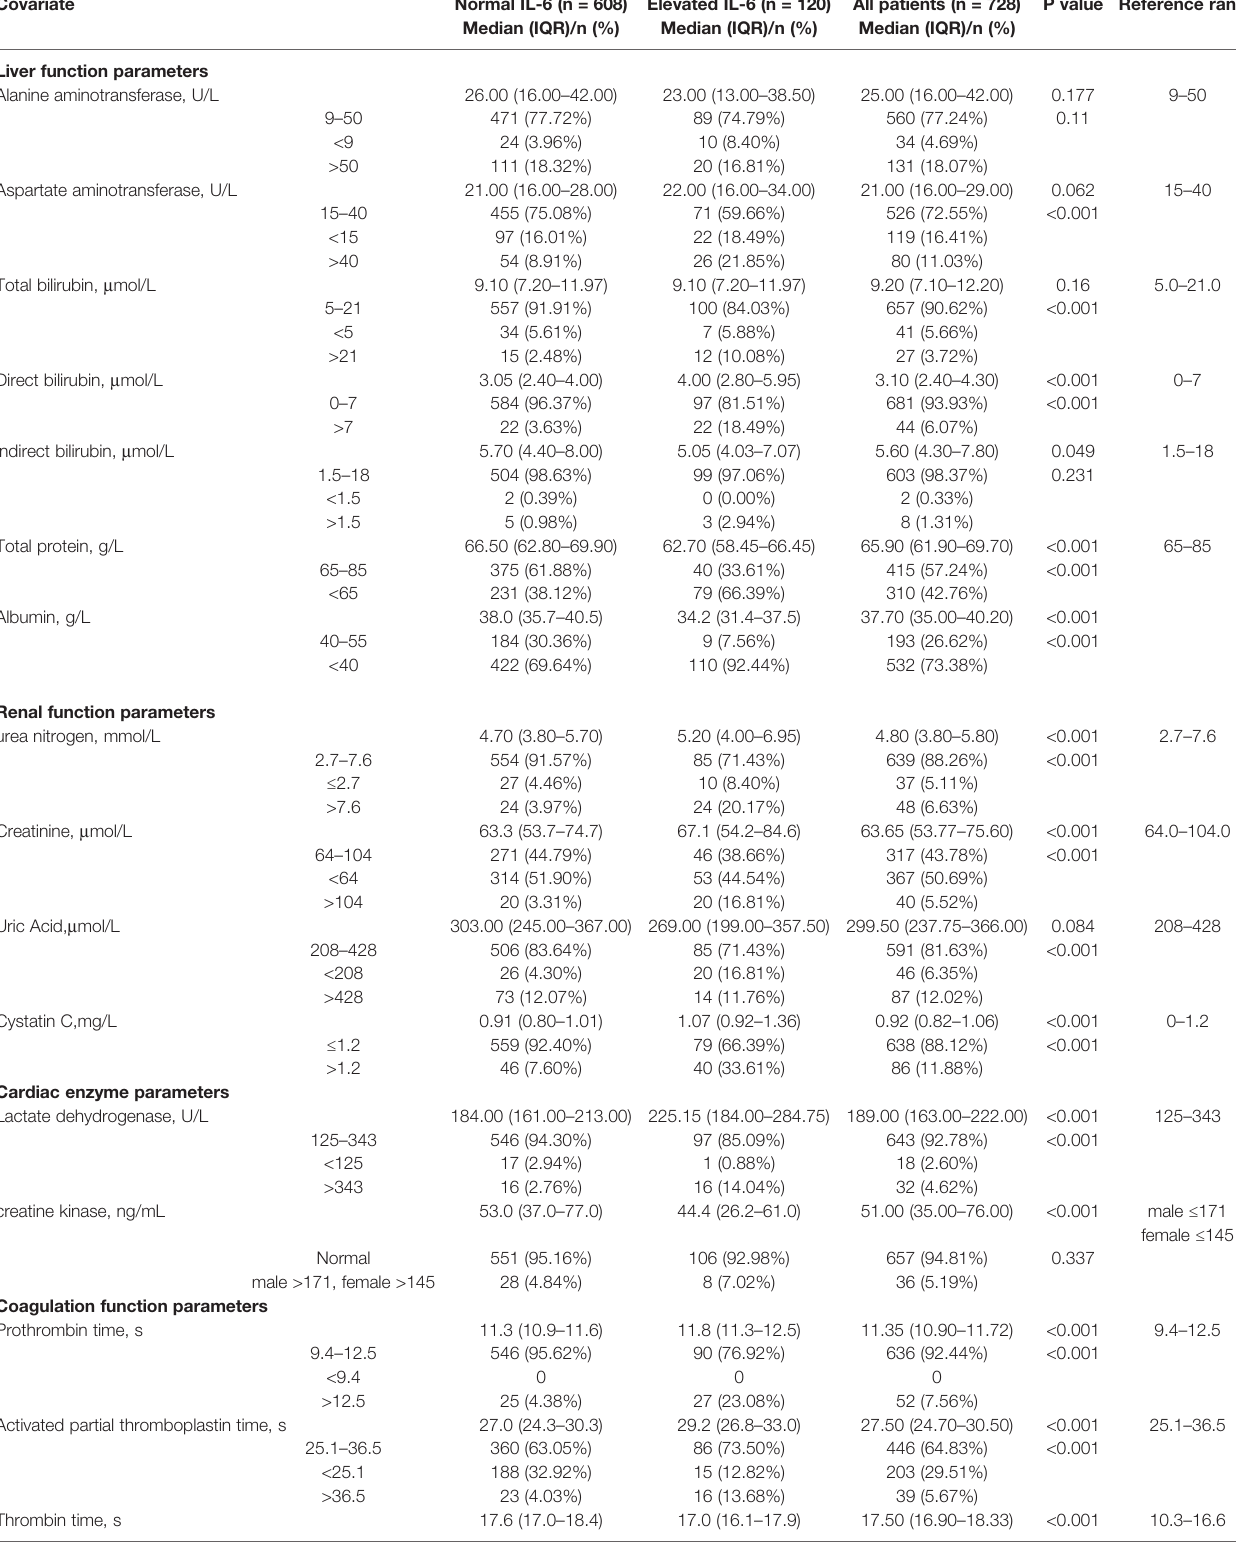
TABLE 2 | Serum biochemical parameters and blood coagulation test results of 728 patients with COVID-19.